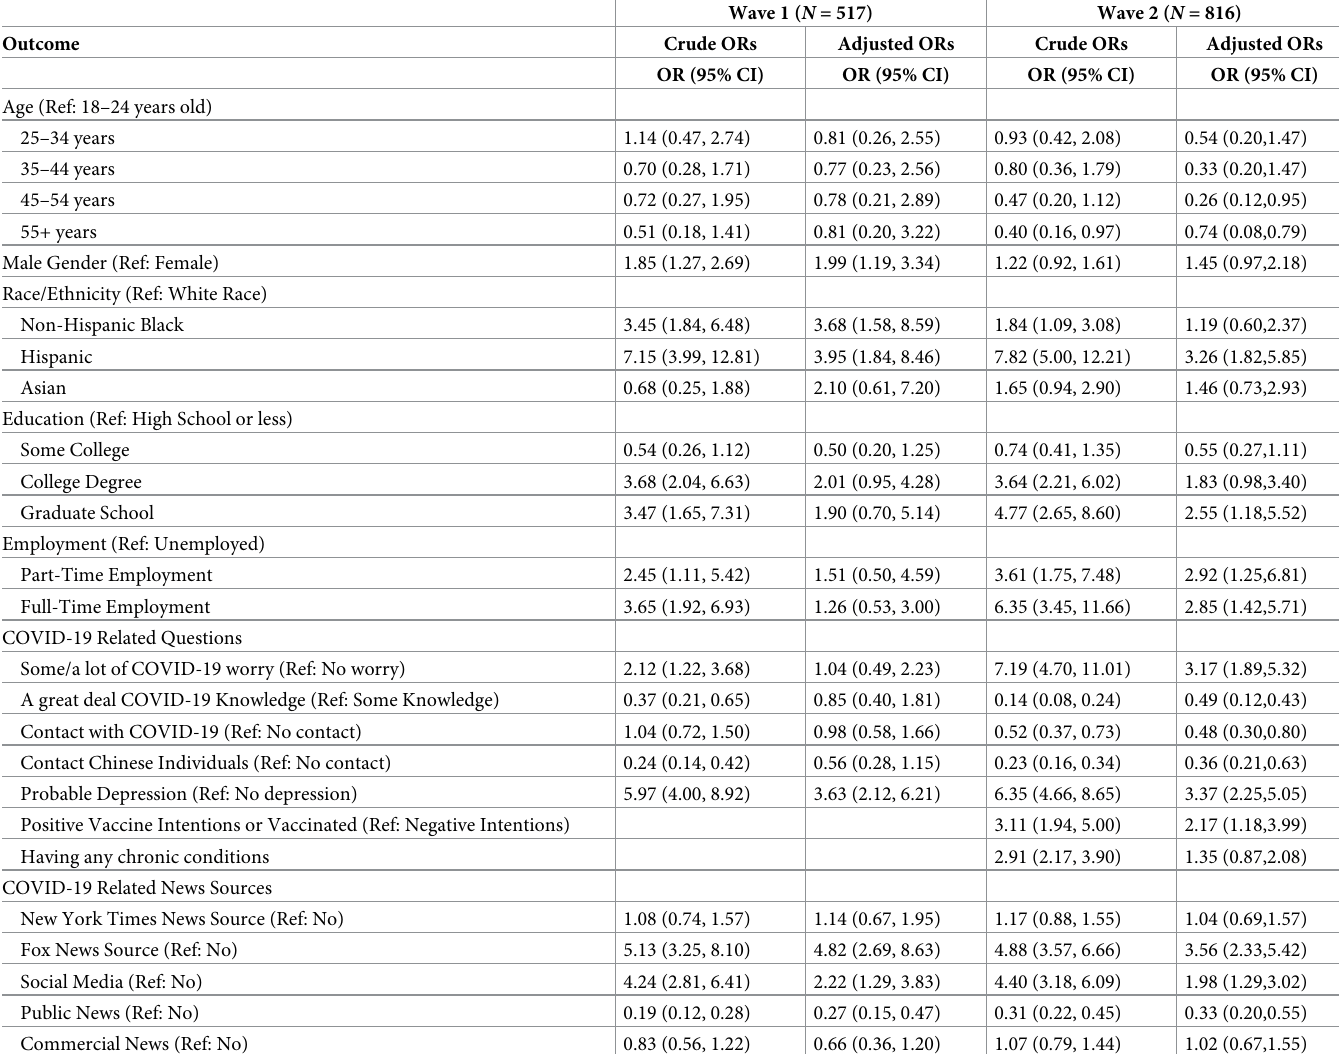
Table 5. Logistic regression results for associations with COVID-19 stigma for Waves 1 (N = 517) and 2 (N =